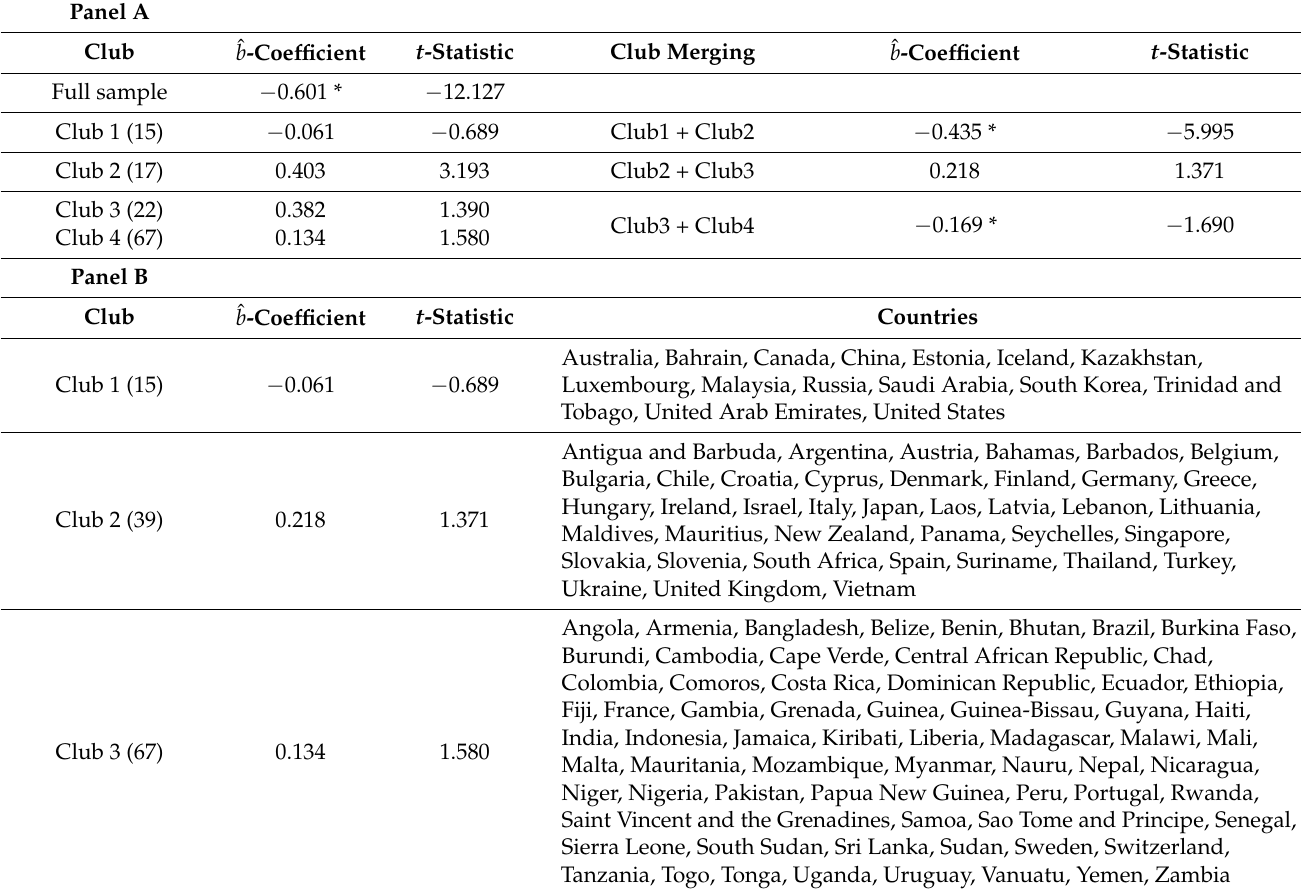
Table 2. Club convergence results.